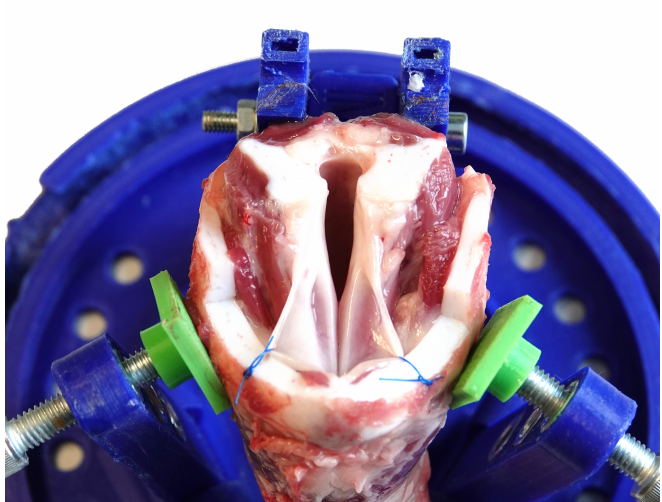
Figure 2. Prepared larynx in holder ready for the measurements. The larynx is held in place by two screws which are fixating the cricoid cartilage against the back plane. To expose the vocal folds and make them accessible more easily, the vestibular folds are sewn to either